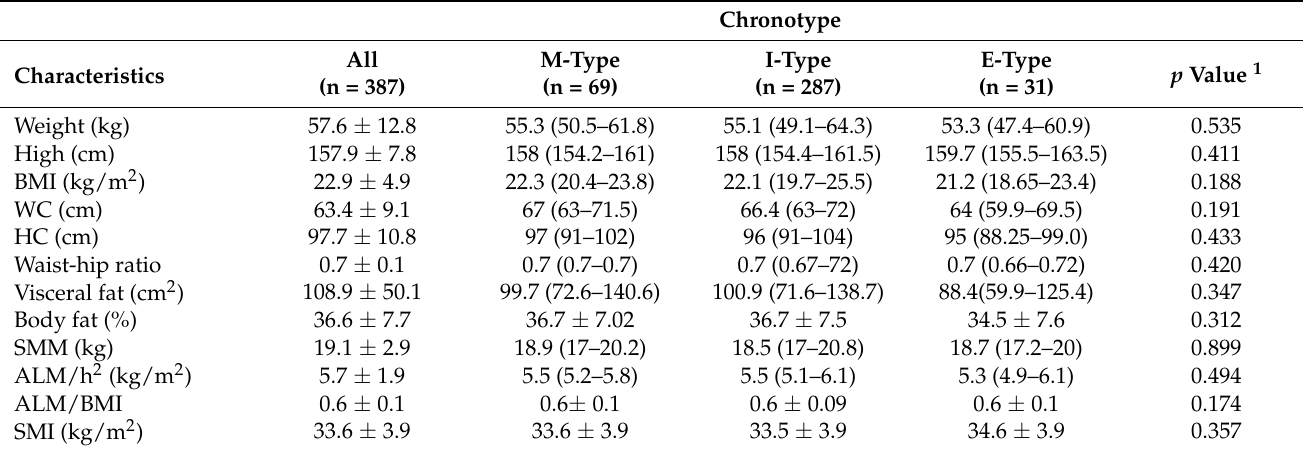
Figure 1. Chronotype categories of the study participants (n = 387). Table 2. Anthropometric measurements for the study participants (n = 387).